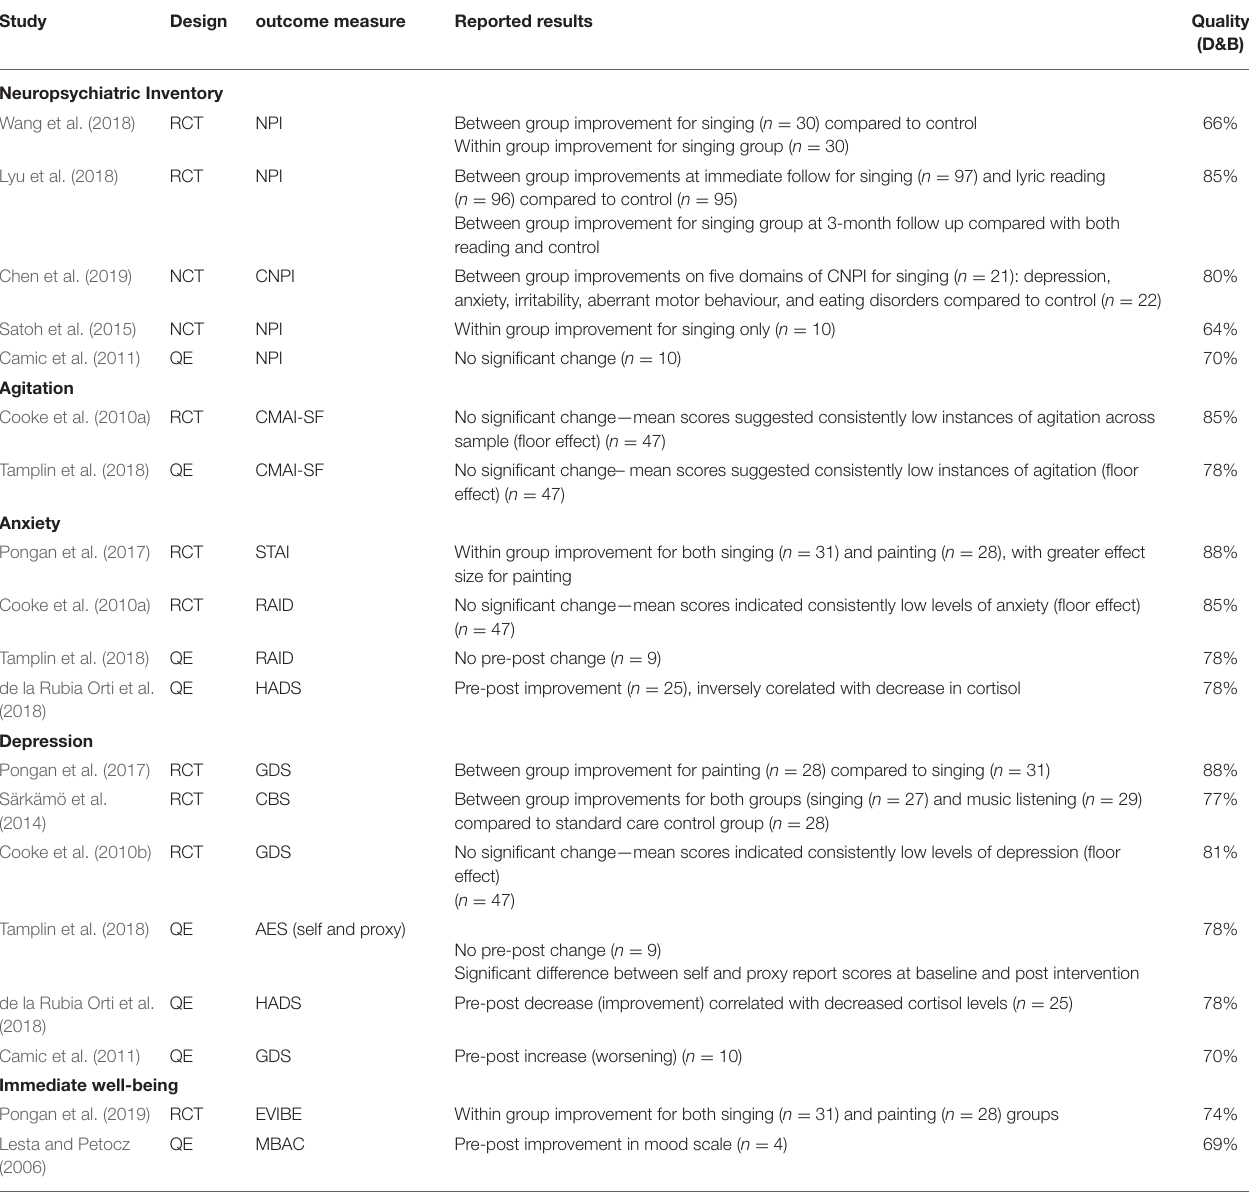
TABLE 4 | Overview of results of psychological wellbeing